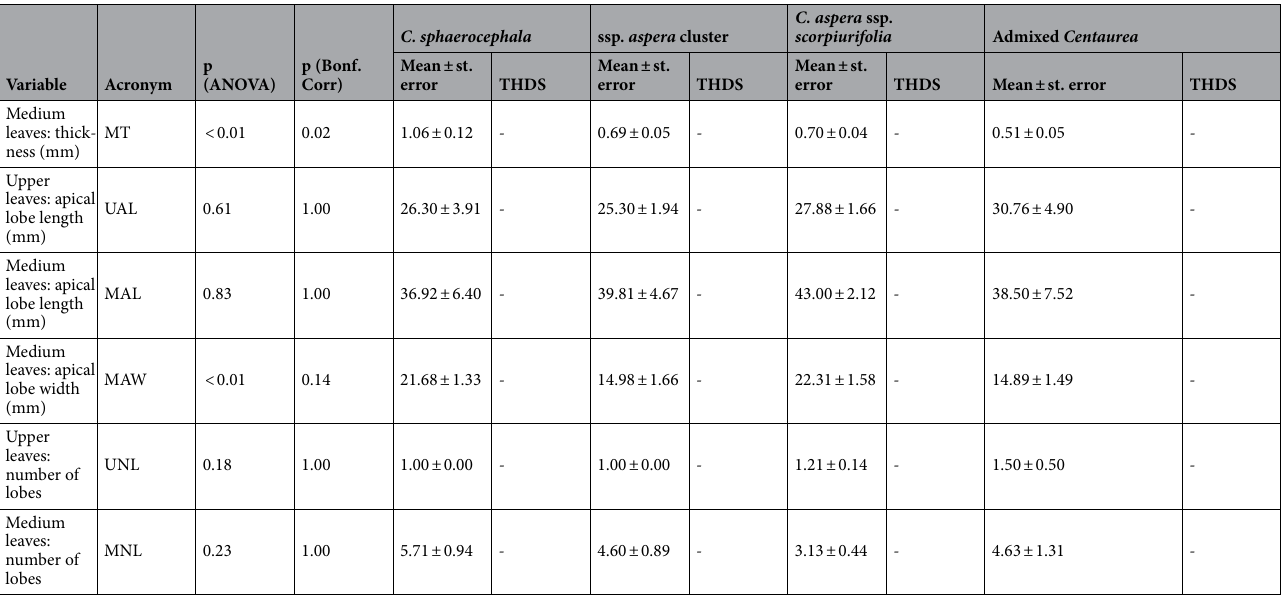
Table 2. ANOVAs of the morphological variables among the Centaurea clusters obtained using STRU CTU RE on genetic characterization (7 C. sphaerocephala , 20 C. aspera cluster, 19 C. aspera ssp. scorpiurifolia , and 4 admixed individuals between the two latter). Bonferroni correction, mean and standard error are indicated. Different letters indicate significant differences between clusters resulting from post-hoc Tukey HSD tests. Asterisks show variables used for PCA. For vegetative binary variables used for PCA, see Supplementary Table S5